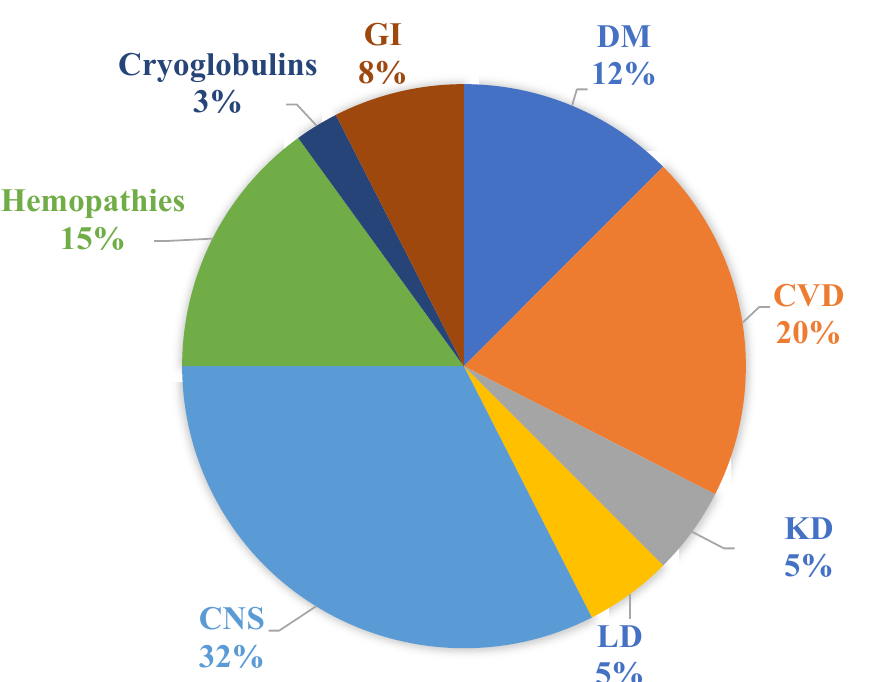
Figure 1. Percentage of comorbidities of the cohort. DM: diabetes mellitus; CVD: cardiovascular diseases; KD: kidney diseases; LD: lung diseases; CNS: central nervous system diseases; GI: gastrointestinal diseases.